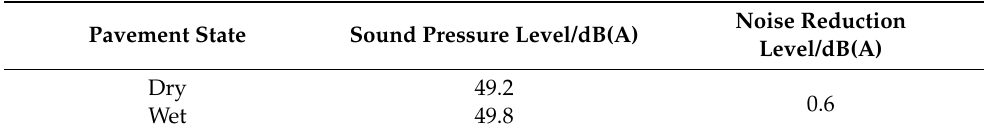
Table 8. A comparison of OGFC pavement noise in dry and wet conditions.